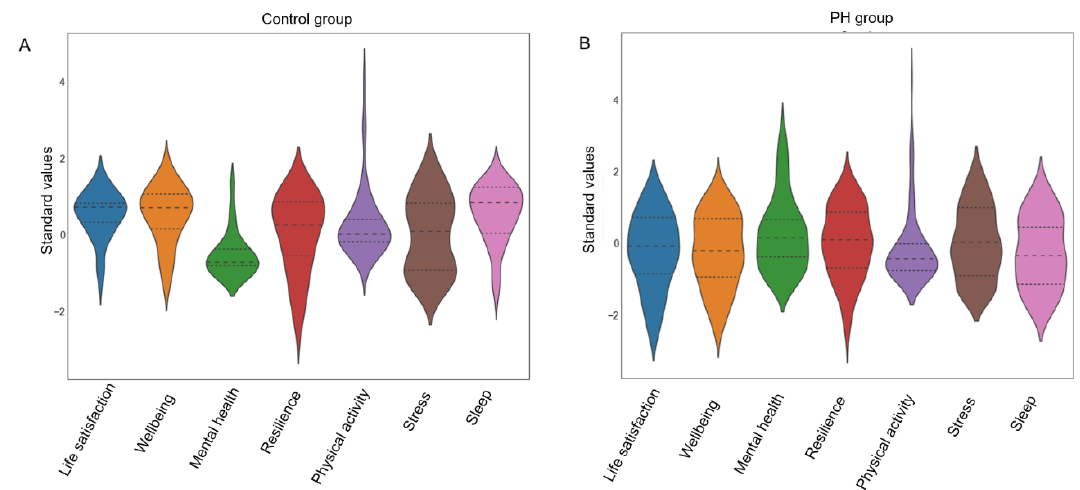
Figure 1. Z-standardized values of mental health variables. ( A ): z-standardized values of life satisfaction, mental wellbeing, mental health, resilience, total physical activity, stress experience, and sleep habits of healthy controls during the lockdown. The dashed inner line of each violin graph reflects the quartiles of each health variable. ( B ) : z-standardized values of life satisfaction, mental wellbeing, mental health, resilience, total physical activity, stress experience and sleep habits of PH patients. The dashed inner line of each violin graph reflects the quartiles of each health variable.